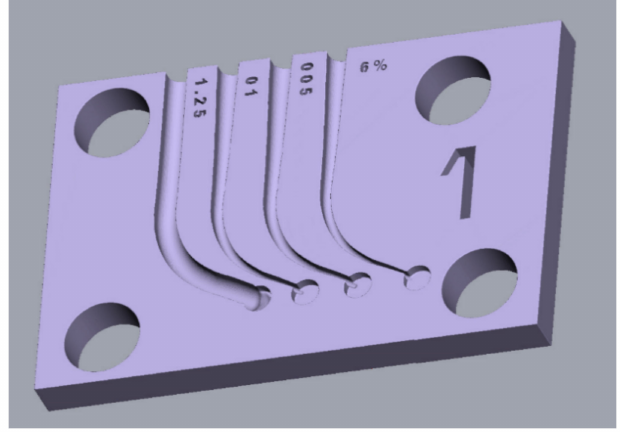
Figure 2. Artificial root canals designed with Geomagic Freeform software.